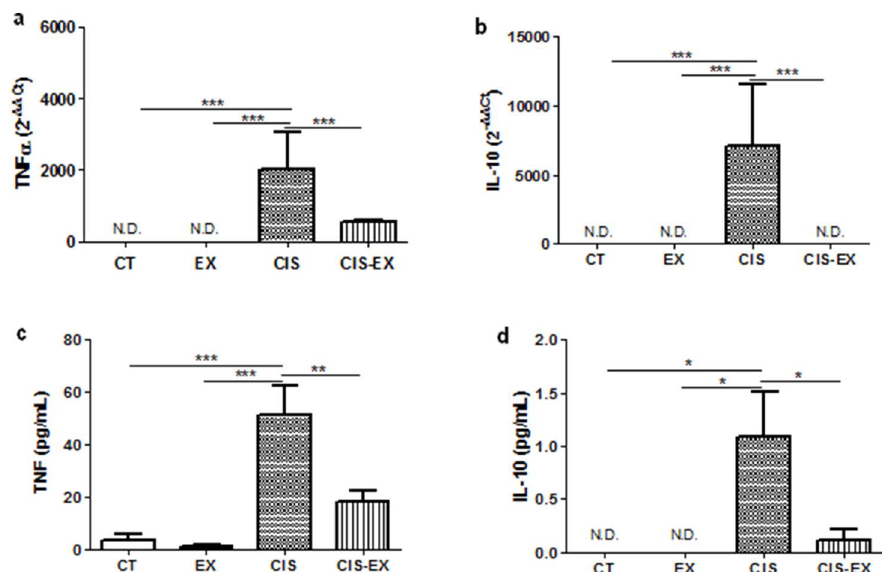
Figure 3. Exercise attenuates inflammation. qPCR analysis revealed that the CIS group showed higher expressions of TNF ( A ) and IL-10 ( B ) in the kidney, while CIS-EX did not exhibit significant differences compared to CT. The serum concentrations of TNF ( C ) and IL-10 ( D ), determined by CBA, appeared to decrease in the CIS-EX group. *P , 0.05; **P , 0.01; ***P , 0.001; N.D. - non detected cytokine.